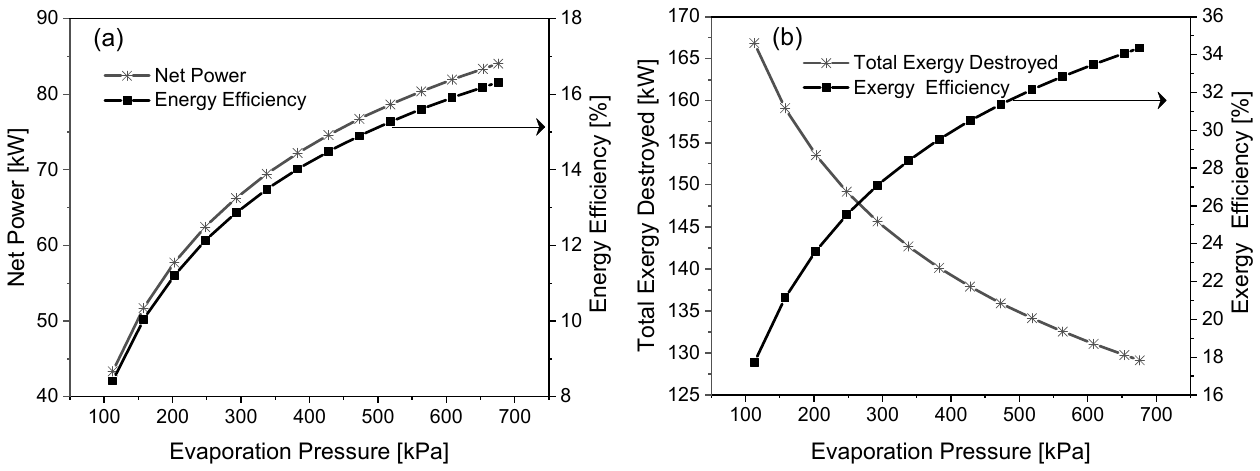
Figure 5. Effect of evaporation pressure on ( a ) net power and energy efficiency, ( b ) destroyed exergy and exergy efficiency.